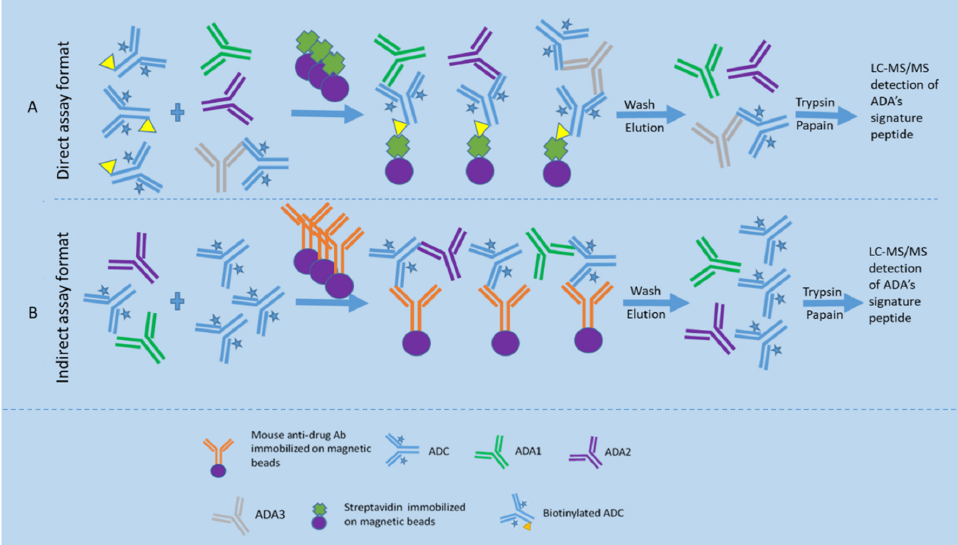
Figure 4. Direct and indirect LBA-LC-MS/MS assay formats for ADA detection. ( A ) shows the direct LBA-LC-MS/MS assay format for detection of ADAs, where samples are pre-incubated with the biotinylated drug to form a biotinylated drug-ADA complex and then captured by the streptavidin magnetic beads. Subsequently, nondrug-specific proteins are removed from the beads by washes. The bound ADAs are eluted by an acidic buffer and followed by neutralization. Thereafter, the eluted antibodies undergo reduction, alkylation, and digestion with trypsin to obtain ADA tryptic peptides. The signature peptides derived from ADAs are chromatographically separated and then detected by measuring each signature peptide under a specific SRM mode; ( B ) shows the indirect LBA-LC-MS/MS assay format for detection of ADAs, where excess drugs are spiked into the serum sample to saturate the ADA binding sites, followed by using a mouse anti-drug monoclonal antibody immobilized on magnetic beads to capture the ADA-drug complex. Thereafter, the ADAs are directly measured by the ADA’s signature